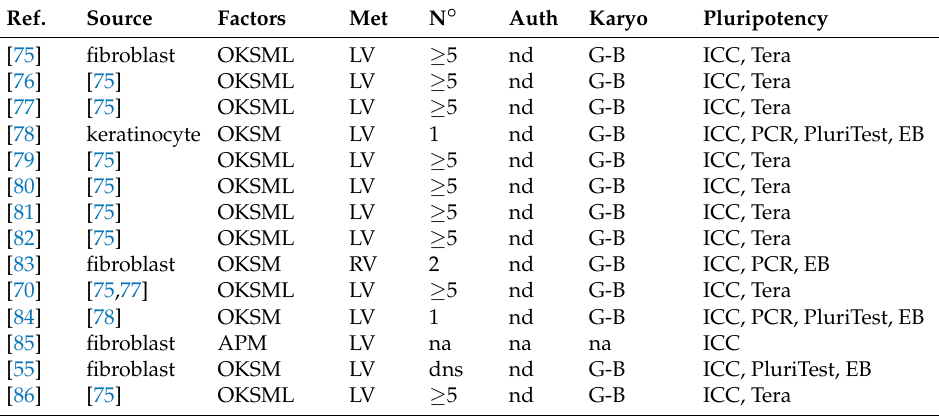
Table 1. Methods for Schizophrenia-induced pluripotent stem cell (SCZ-iPSC) generation and quality